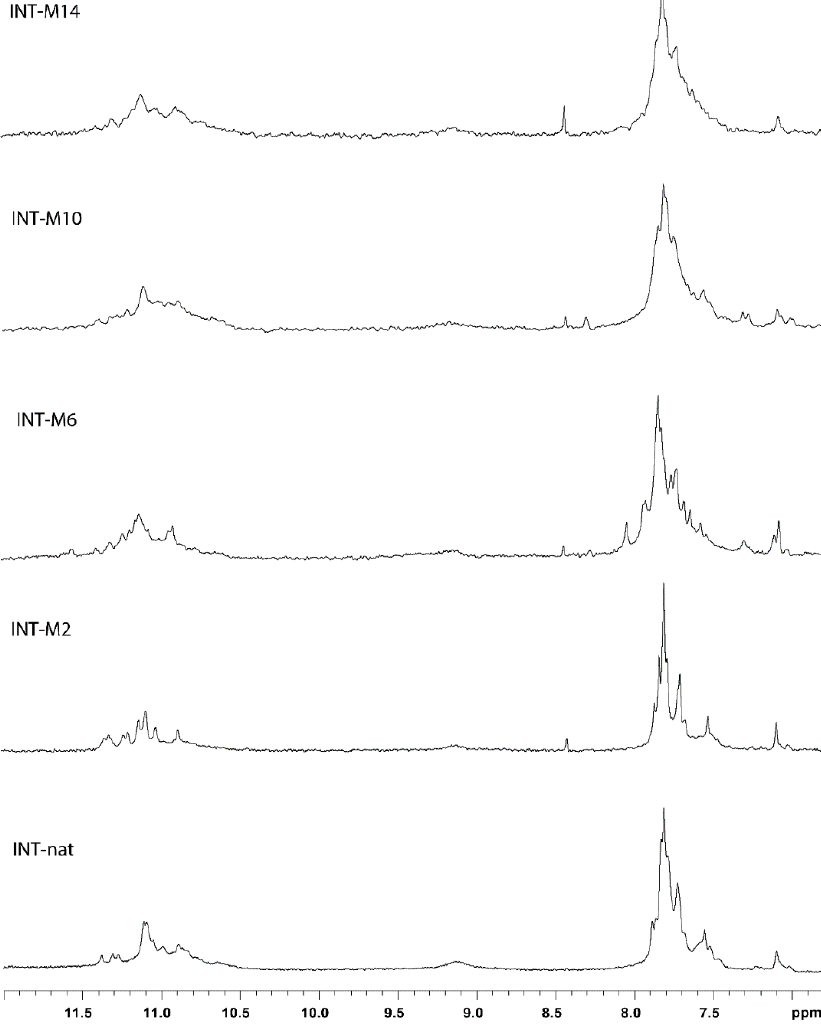
Figure 2. Imino and aromatic proton regions of the 1 H-NMR spectra (500 MHz) of the T30923 analogues investigated. See Materials and Methods for experimental details. investigated. See Materials and Methods for experimental